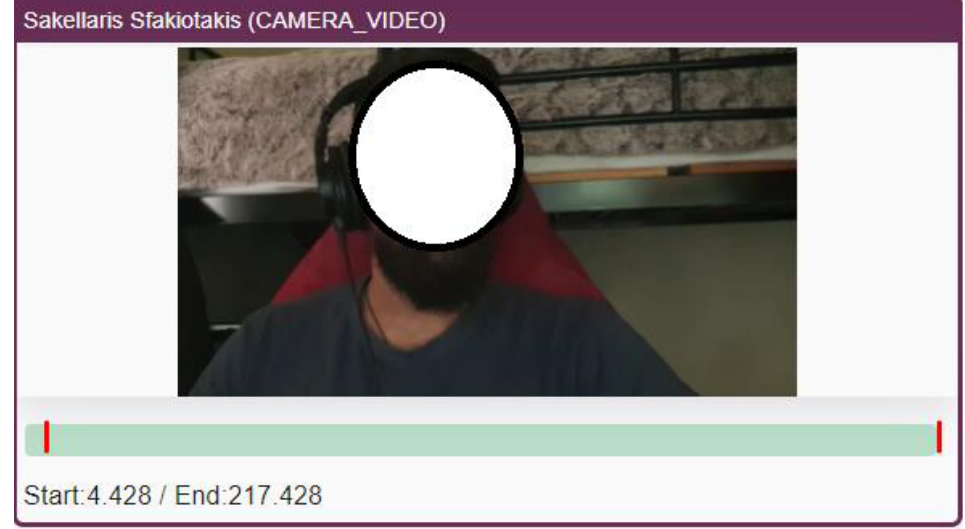
Figure 10. Camera Video modality with start and end event.